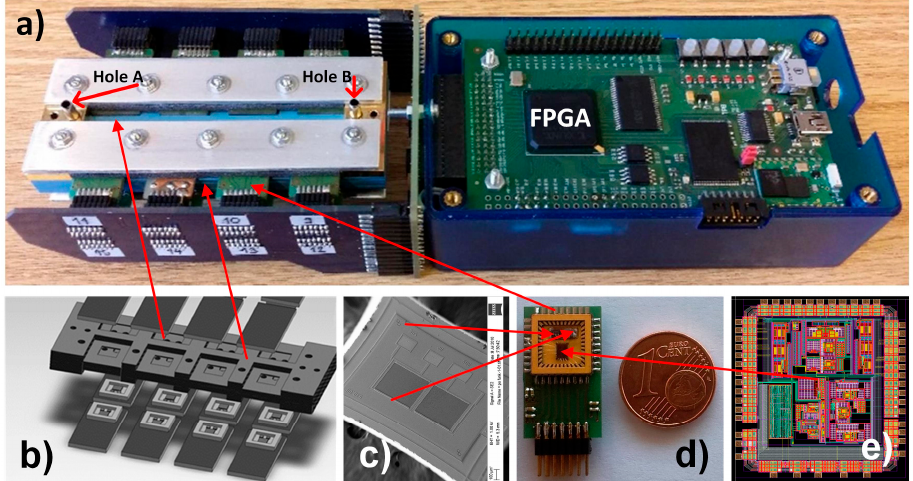
Figure 6. Sixteen-channel vapour trace detection system: ( a ) Implemented detection system without gas generator, where inlets A and B are connected to the gas generator. ( b ) Ceramic gas distribution system and SiP holder, ( c ) One differential sensor, ( d ) SiP composed of one ASIC and two differential sensors, ( e ) layout of the ASIC that implements one channel lock-in amplifier that is capable to process the signals from 4 differential sensors.